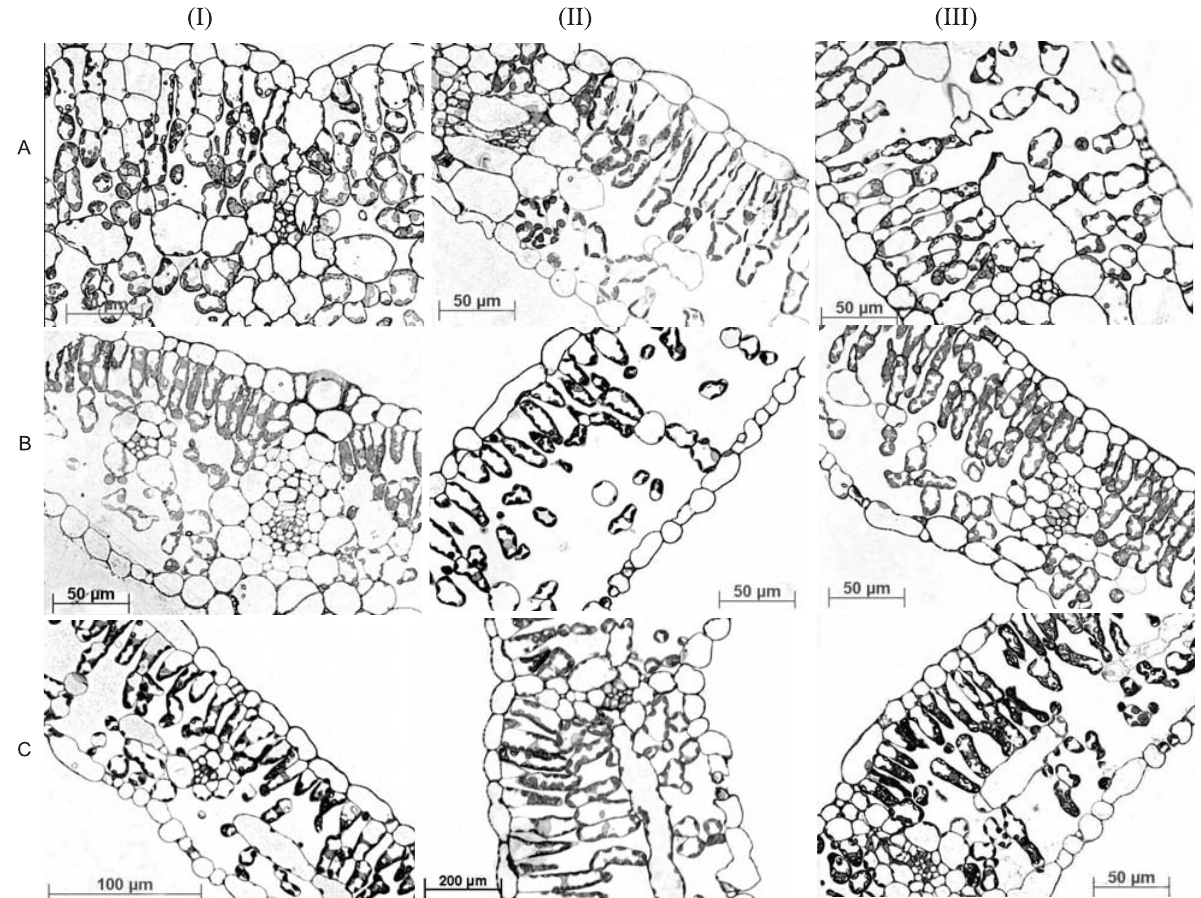
Figure 3. Leaf blade cross-sections of three soybean cultivars: Santa Rosa (I); IAC-15 (II) and IAC-Foscarin 31 (III), as related to Mn rates of 0.5 μμμμμ mol L -1 (A), 2.0 μμμμμ mol L -1 (B) and 200.0 μμμμμ mol L -1 (C), in the nutrient solution. Anatomical features of the leaf tissues: mesophyll cell of the palisade parenchyma (two cell layers in the upper leaf surface – as related to Mn rates of 2.0 and 200.0 μμμμμ mol L -1 ) and spongy parenchyma (a single layer of spongy cells in the abaxial